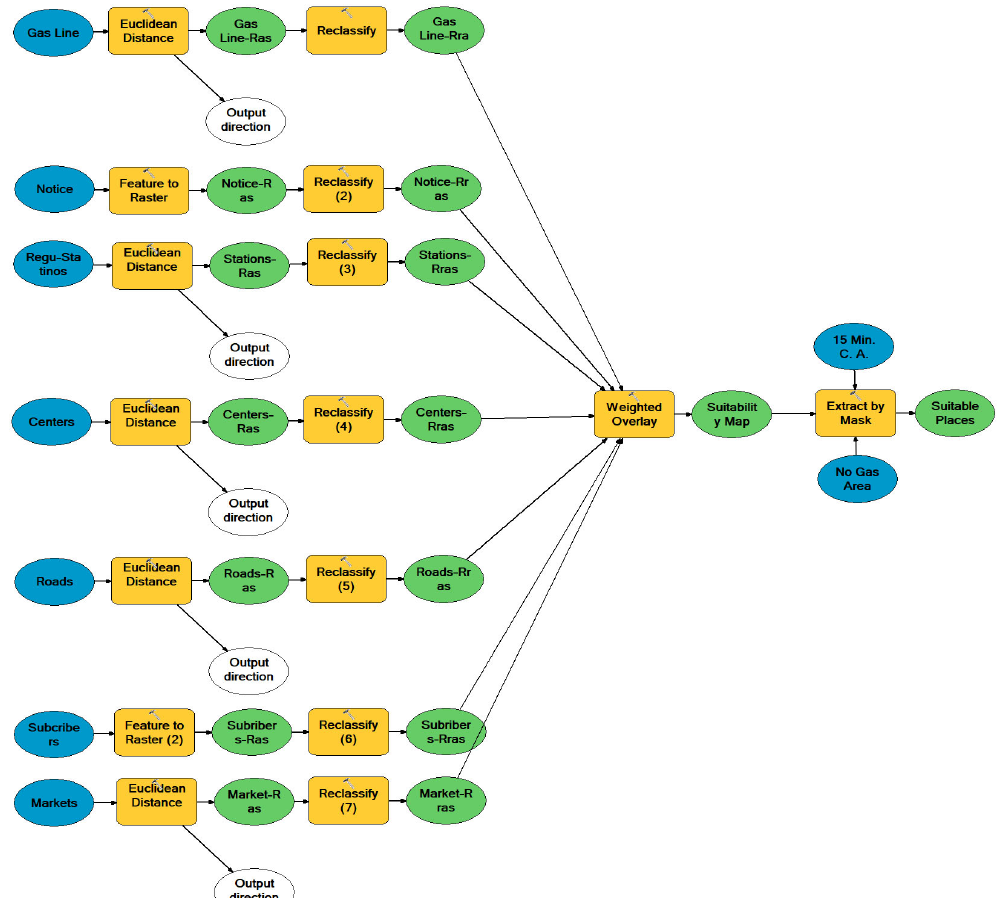
Figure 5. New natural gas emergency response team center location analysis model.